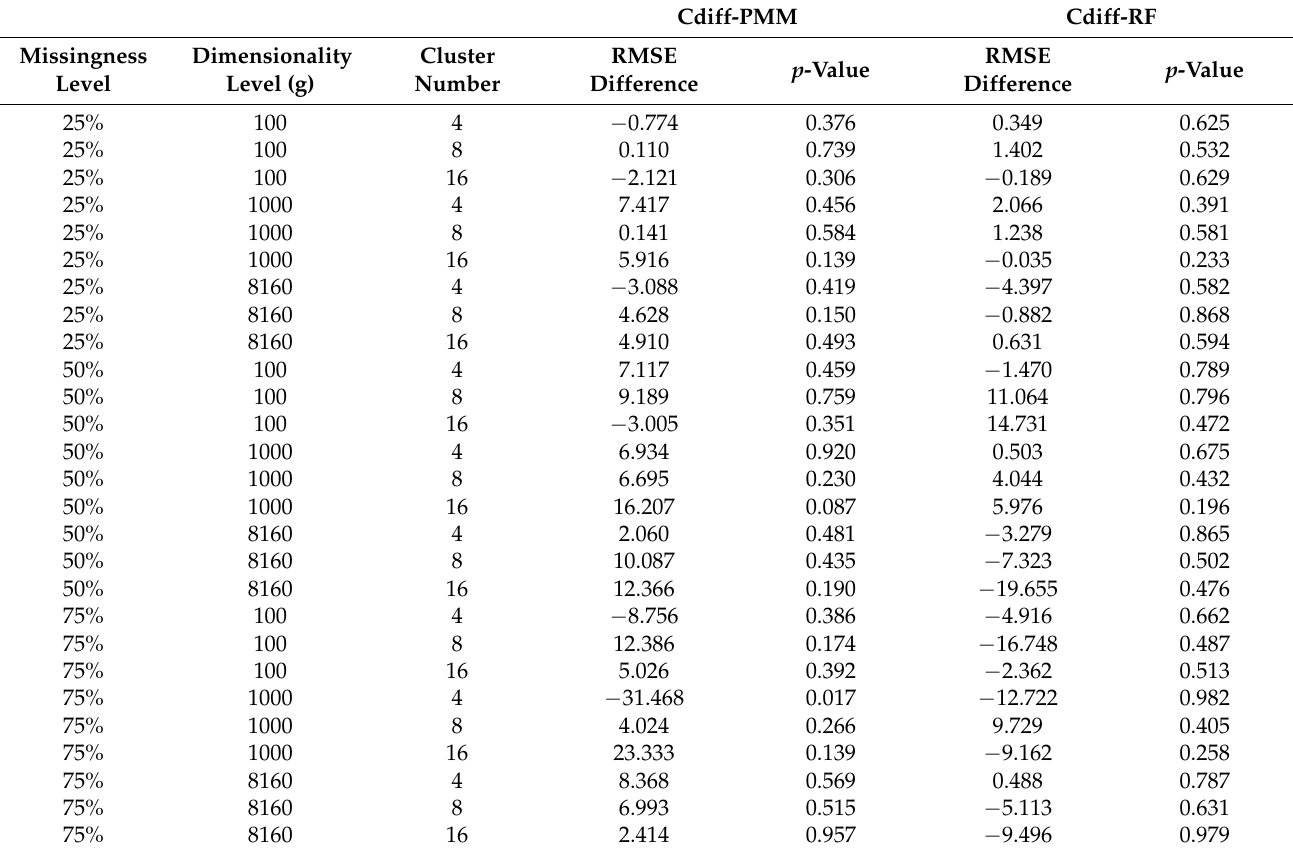
Table A3. The RMSE difference from imputation is applied with and without the integration of comorbidity information for the Cdiff dataset. Negative RMSE correspond to improvement by the hybrid approach. The pmm and rf models in MICE were used in this study. The p -value is reported based on 10 runs.